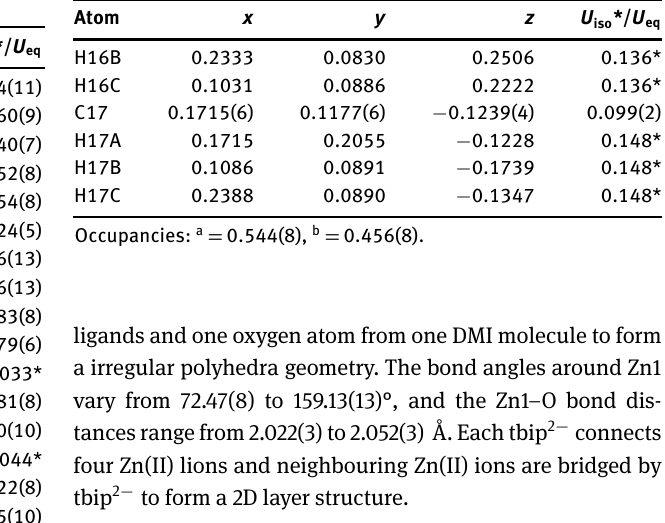
Table 2: Fractional atomic coordinates and isotropic or equivalent isotropic displacement parameters (Å 2